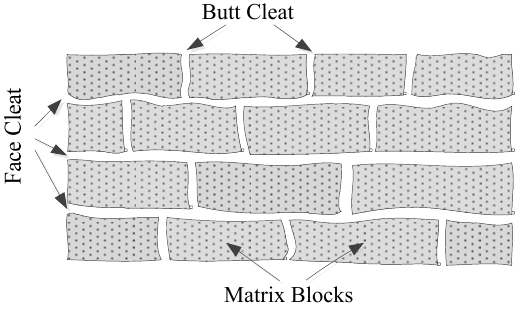
Figure 1. Conceptual schematic of a coal fracture or a cleat system.